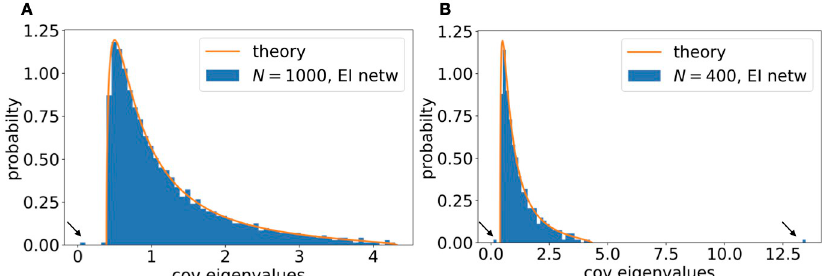
Fig 6. EI networks. A . One realization of the covariance eigenvalues by Eq (2) with an EI network satisfying the stability condition (see text). The bulk spectrum is well described by the Gaussian random connectivity theory (solid line, Eq (5)). There is one small outlier to the left of the bulk (arrow). The parameters are g = w 0 = 0.4, p ffiffiffiffiffi p ffiffiffiffiffi p ffiffiffiffiffi ¼ 1 : 5 , ¼ 1 , ¼ 2 , K = 60, N = 1000. To improve the accuracy of the theory to finite K , N , here we use a k k k ffiffiffiffiffiffiffiffiffiffiffiffiffiffiffiffiffiffiffiffiffiffiffiffiffiffiffiffiffiffiffi q ei ie ii slightly modified connection weight, w = , for all excitatory non-zero connections, and similarly K ab ð 1 (cid:0) K ab = N Þ 0 ffiffiffiffiffiffiffiffiffiffiffiffiffiffiffiffiffiffiffiffiffiffiffiffiffiffiffiffiffiffiffi q (cid:0) w = for inhibitory connections, such that var ð J Þ ¼ w 2 = N holds exactly for finite N . B . Similar as K ab ð 1 (cid:0) K ab = N Þ 0 0 ij A but for balanced EI network (see text) with k αβ = k = 1, g = 0.4, K = 40, N = 400. Note there are two outliers on both sides of the